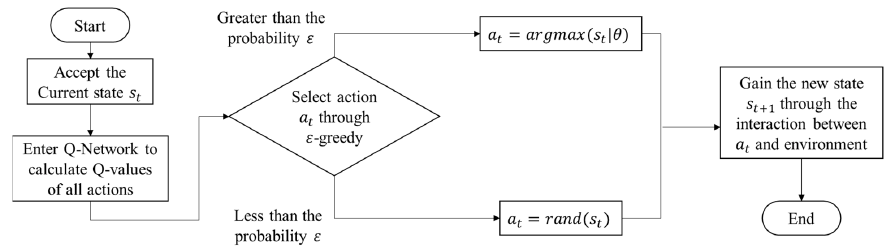
Figure 11. Flowchart of the interaction stage.